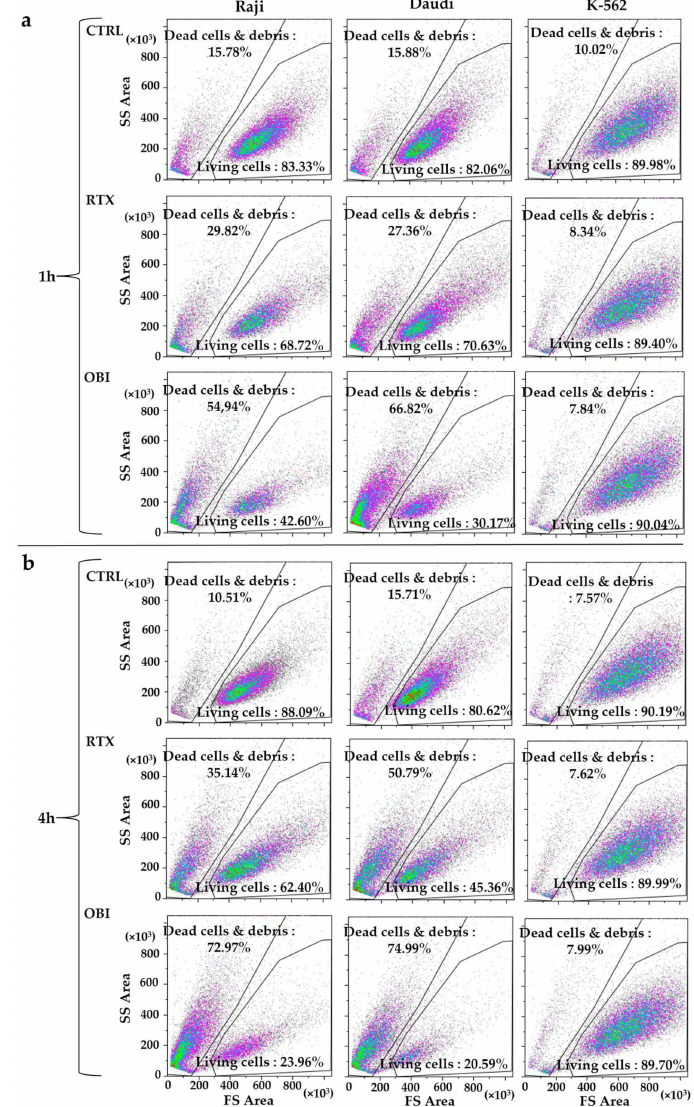
Figure 3. RTX and OBI induce a quick cell death measured by changes in cell morphology. The depicted cell lines (1 million/mL) were incubated with RTX or OBI (10 µ g/mL) for the indicated times. Then, cells were directly analyzed by FACs with neither washing nor centrifugation steps. Doublets and very small debris were removed as described in Figure S1. ( a ) One hour post-treatment; ( b ) four hours post-treatment. Each graph displays 20,000